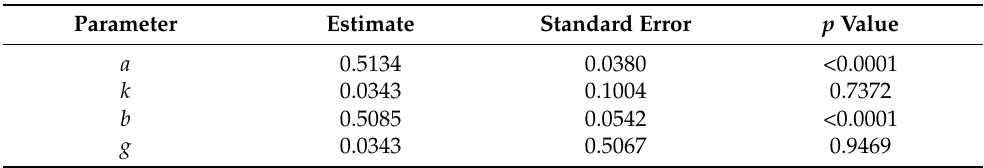
Table 3. Parameter estimates, standard errors and p values of the two-term model [Equation (7)] to the data shown in Figure 4.